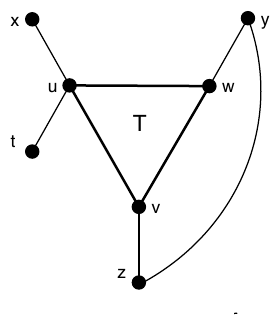
Figure 3: A triangle with four sidekicks.